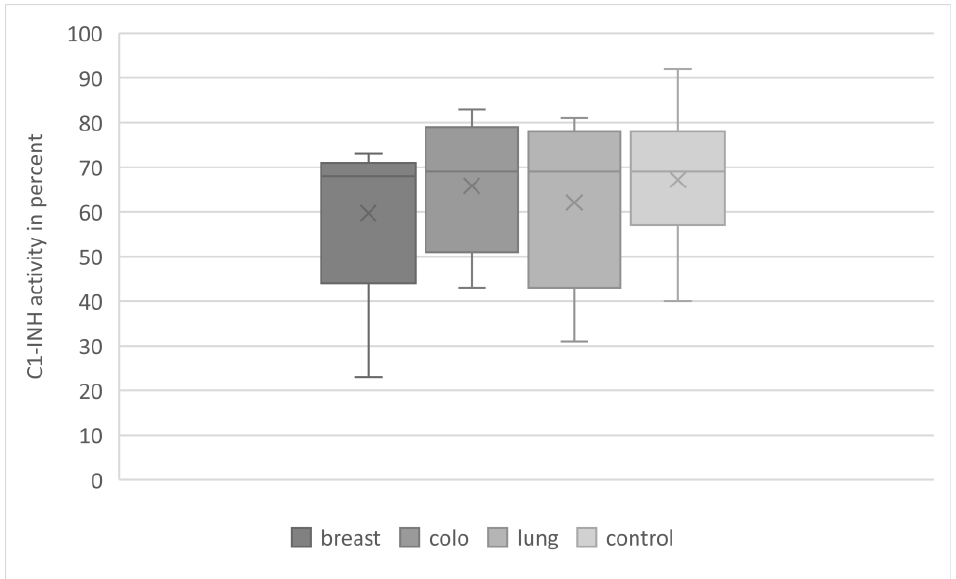
Figure 2. C1-INH activity in study groups with C1-INH-AAE. Legend: C1-INH: C1 inhibitor; breast — breast cancer; colo — colorectal cancer; lung — lung cancer.